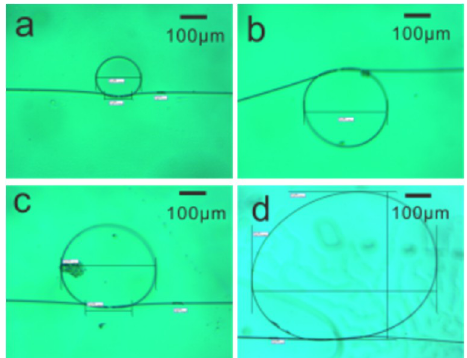
Figure 1. Optical micrographs of the as-fabricated microfiber knot resonators (MKRs) with ring diameters of 155 μm ( a ), 289 μm ( b ), 328 μm ( c ), and 594 μm ( d ).